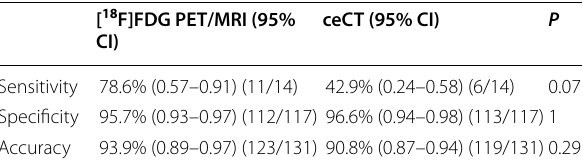
Table 6 Comparison of [ 18 F]FDG PET/MRI and ceCT for lesion-based nodal